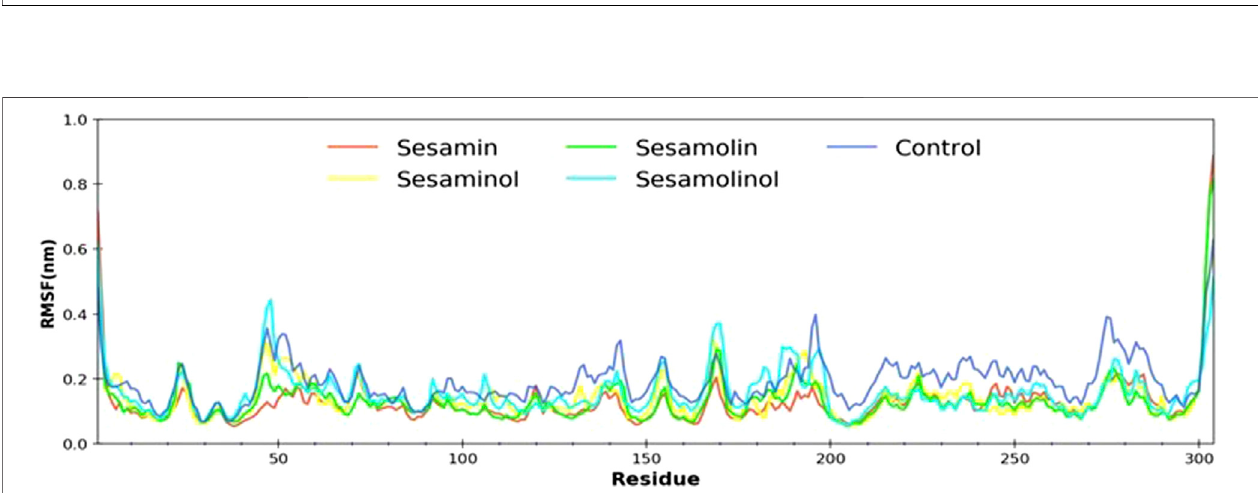
FIGURE5| CalculatedRMSFplotofdockingcomplexes[M pro – sesamincomplex(red),M pro – sesamolincomplex(green),M pro – sesaminolcomplex(yellow),M pro – sesamolinol complex (cyan), and control (blue)].